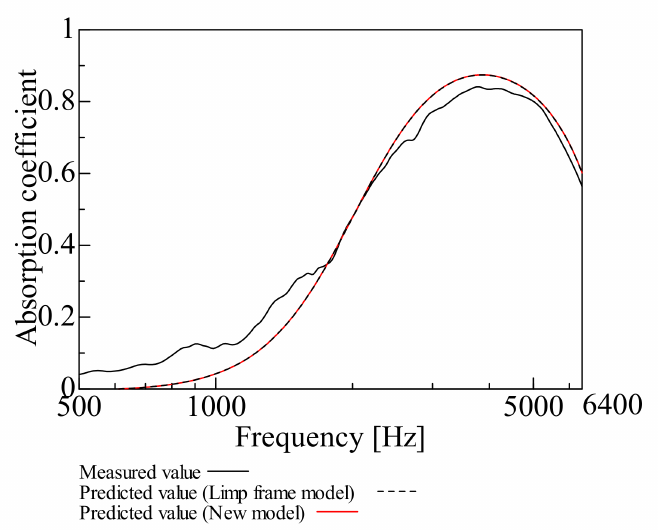
Figure 9. Comparison between the experiment and prediction (Sample A, m = 0.2 g/m 2 , t = 60 µ m, ρ = 303 kg/m 3